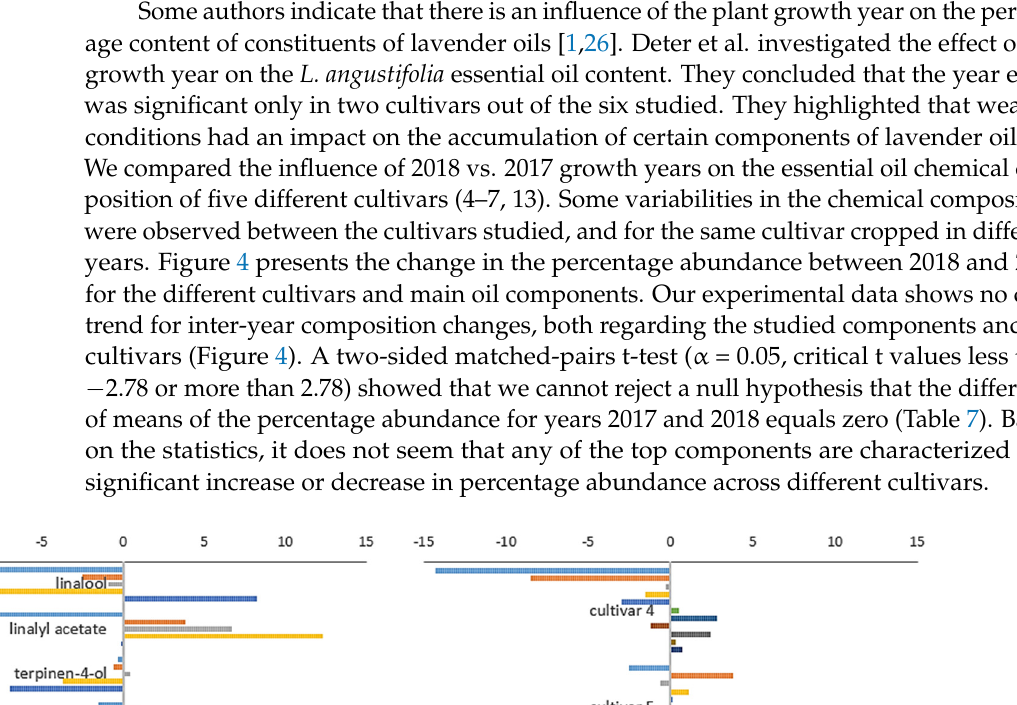
Table 7. The results of paired t-test (two-sided) for top lavender oil component change trends between 2018 and 2017 from five different cultivars. The sample size for statistics was 5 (n = 5), and the degrees of freedom df = 4. The null hypothesis was that the content difference between the years is equal to 0. The alternative hypothesis was that it is not equal to zero.